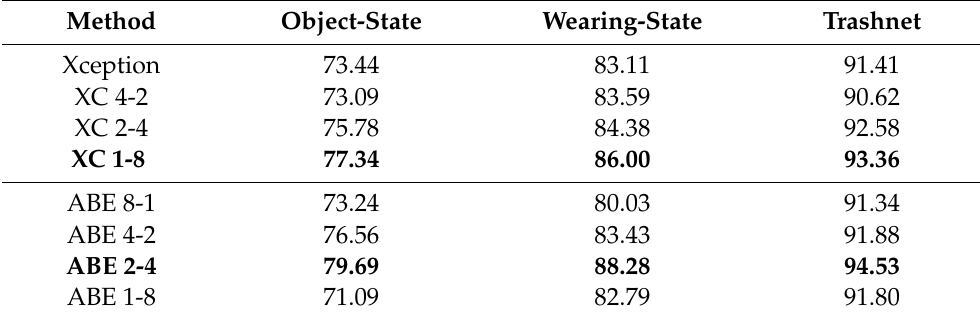
Table 5. Longitudinal comparison of the 4 “ABE Depth-Width” models and horizontal comparison of models in pairs with the same structure on the 3